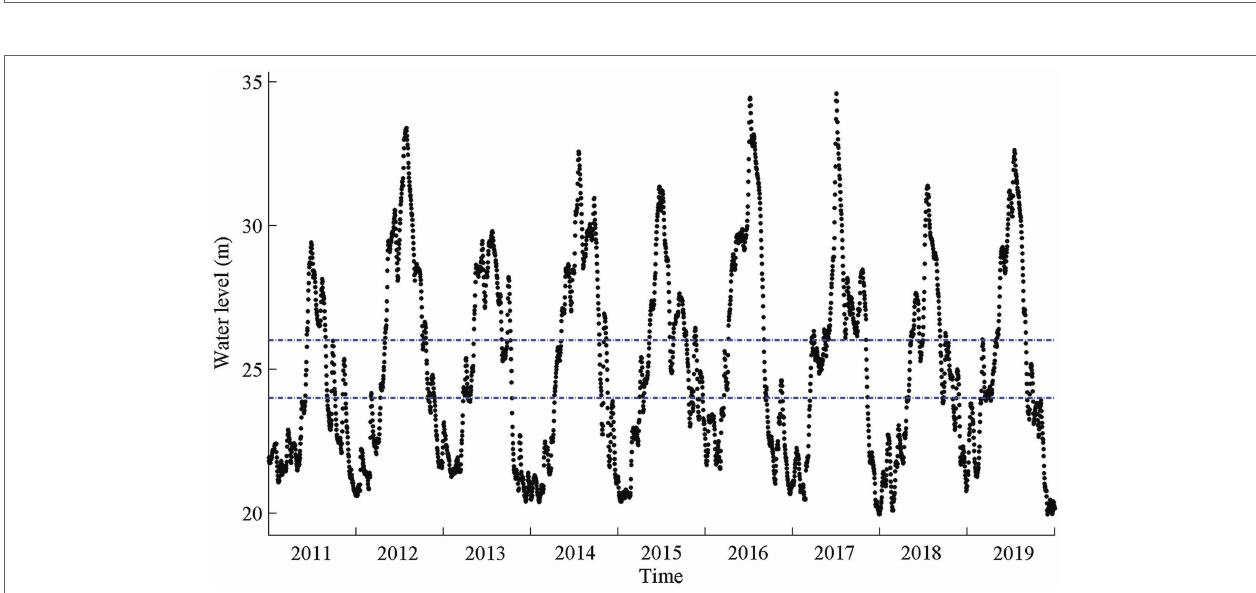
FIGURE 3 | Daily water levels in the Chenglingji Hydrological Station during 2011–2019. The blue dashed lines that are parallel to X-axis indicate the ranges of elevations at the field sampling